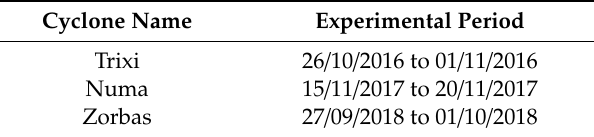
Table 2. Cyclones and experimental periods.